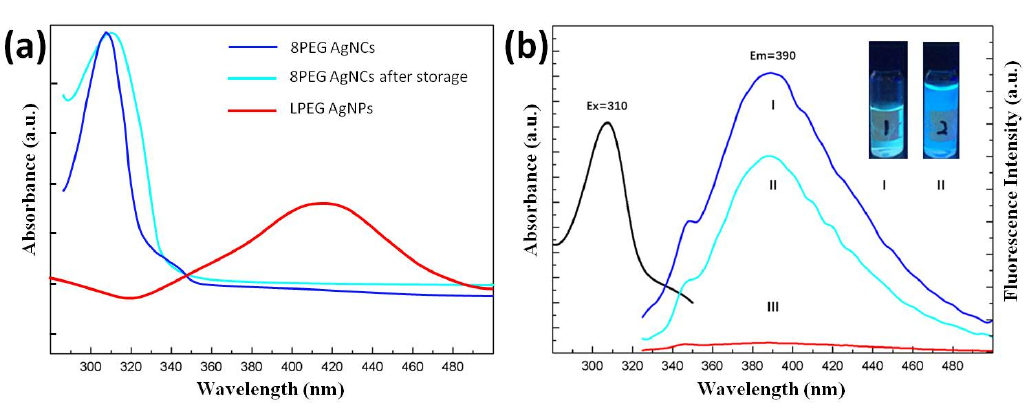
Figure 7. ( a ) UV/vis absorption spectra and ( b ) fluorescence spectra of fresh ( Ι ), reserved 8PEG- Figure 7. ( a ) UV / vis absorption spectra and ( b ) fluorescence spectra of fresh (I), reserved 8PEG-AgNCs AgNCs solution ( ΙΙ ) and linear PEG-AgNCs solution ( ΙΙΙ ). Inset: photographs of fresh ( Ι ) and reserved solution (II) and linear PEG-AgNCs solution (III). Inset: photographs of fresh (I) and reserved 8PEG-AgNCs solution ( ΙΙ ) under and UV light excitation. 8PEG-AgNCs solution (II) under and UV light